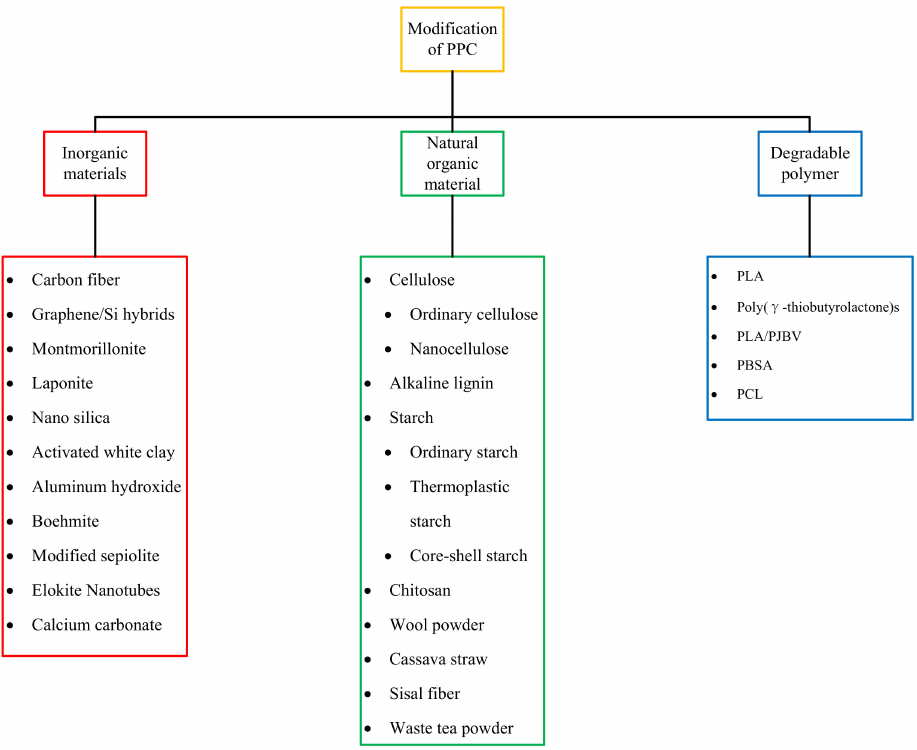
Figure 7. Some materials that can be used for PPC